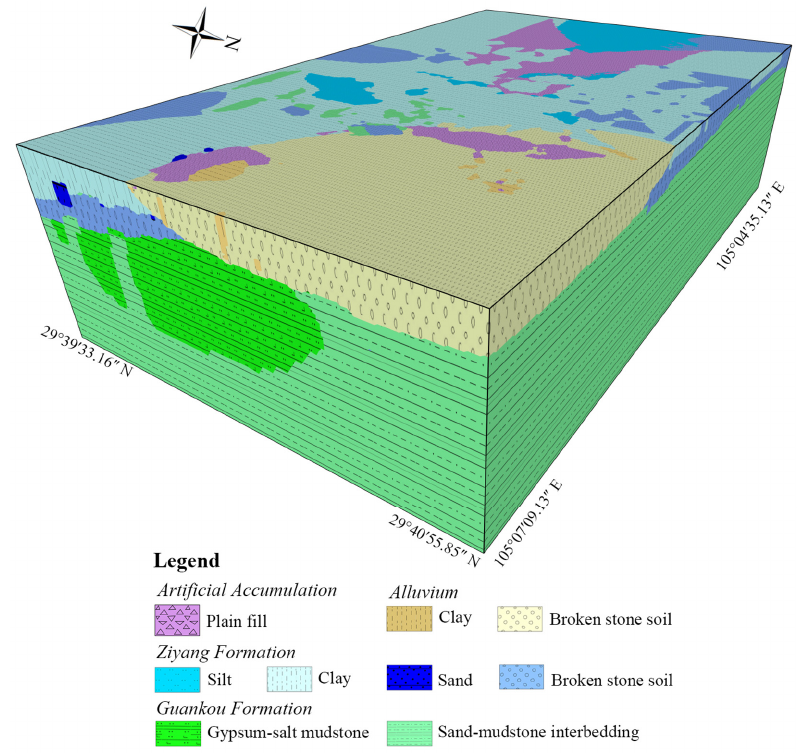
Figure 3. Model result for progressive geological modeling. Color families were used to distinguish strata, and textures were used to mark lithologies. (1) Color family. Purple: artificial accumulation, yellows: alluvium, blues: Ziyang Formation, greens: Guankou Formation. (2) Texture. Triangles: plain fill; vertical dotted lines: clay; circles: broken stone soil; dotted pairs: silt; horizontal lines and single points: sand; horizontal lines and dotted pairs: gypsum–salt mudstone; horizontal dotted lines: sand–mudstone interbedding.